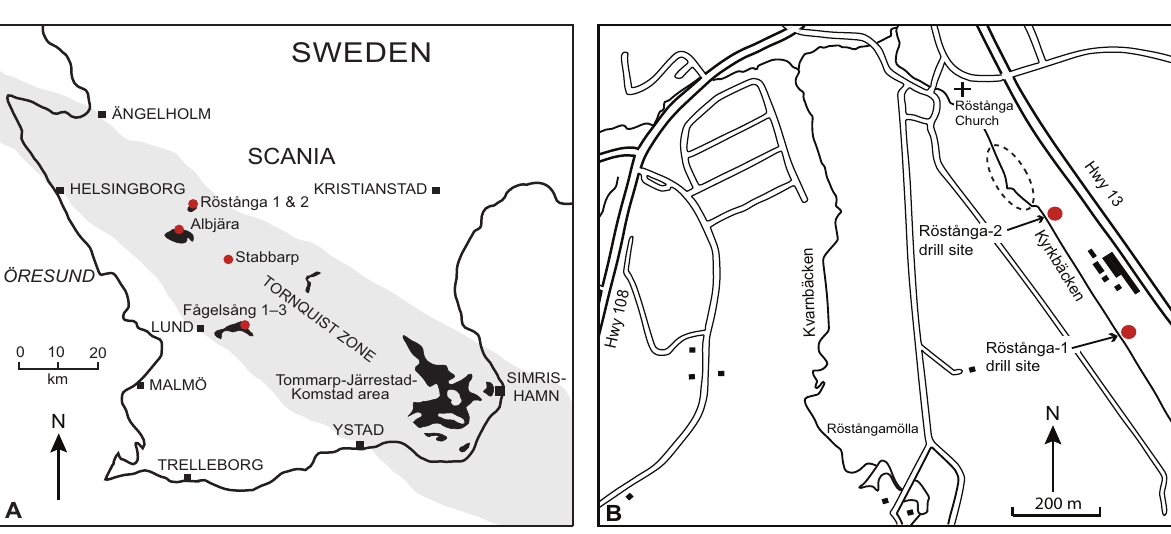
Fig. 1. A , sketch map of Scania (Skåne), southern Sweden, showing Ordovician outcrop areas (black) and the geographic position of localities discussed in the text. Modified after Maletz et al. (2020, fig. 1). B , detailed map of the Röstånga area west of Highway 13 showing the location of the Röstånga­1 and Röstånga­2 drill sites and the Church Brook (Kyrkbäcken). The small exposures of Darriwilian strata, where Hadding (1913) and Ekström (1937) made their excavations, are along the west side of the brook (stippled oval) a short distance northwest of the Röstånga­2 drill site. Modified after Maletz et al. (2020, fig.